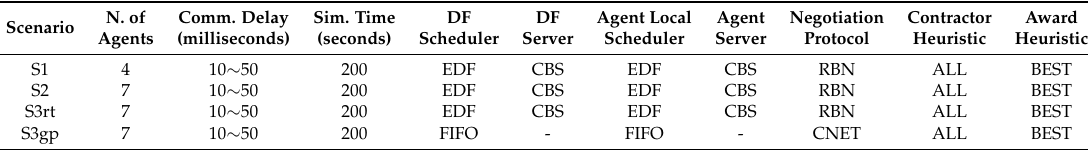
Table 1. General setup of the